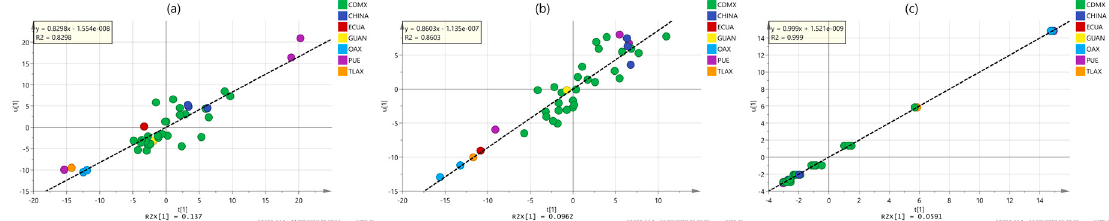
Figure 4. Inner relationship plots for the X-scores (u-data) and Y-scores (t data) between the first latent variables of the OPLS models for ( a ) flavonoid content; ( b ) antioxidant (DPPH) content; and ( c ) antimicrobial S. mutants MIC activity, labeled according to their origin: Mexico City (CDMX), Puebla (PUE), Oaxaca (OAX), Guanajuato (GUAN), Tlaxcala (TLAX), Ecuador (ECUA) and China (CHINA). Inside the figures the lineal regression equation and determination coefficient value of the data are reported.